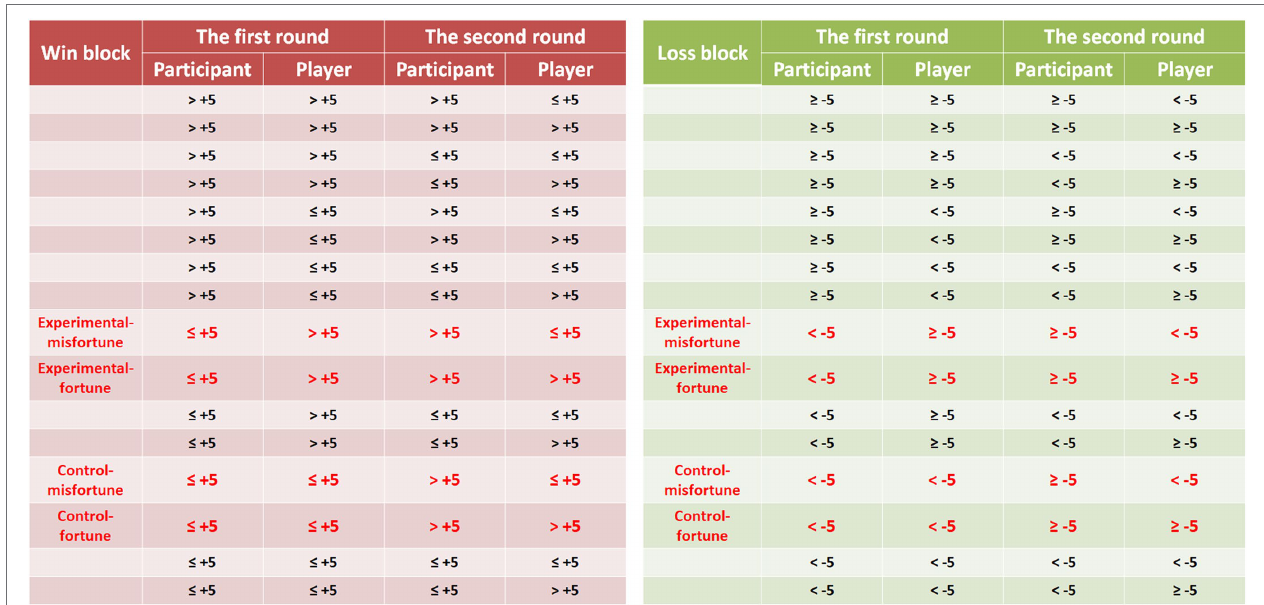
FIGURE 4 | The approximate outcomes between the participants and players for the two rounds of the game in the win and loss block (on the left and right panel, respectively) in Experiment 2. The outcomes in red are those in the experimental and control conditions. The first round of the game is to elicit envy and non-envy emotions, and the second round is to assess the feelings of pleasure (schadenfreude).